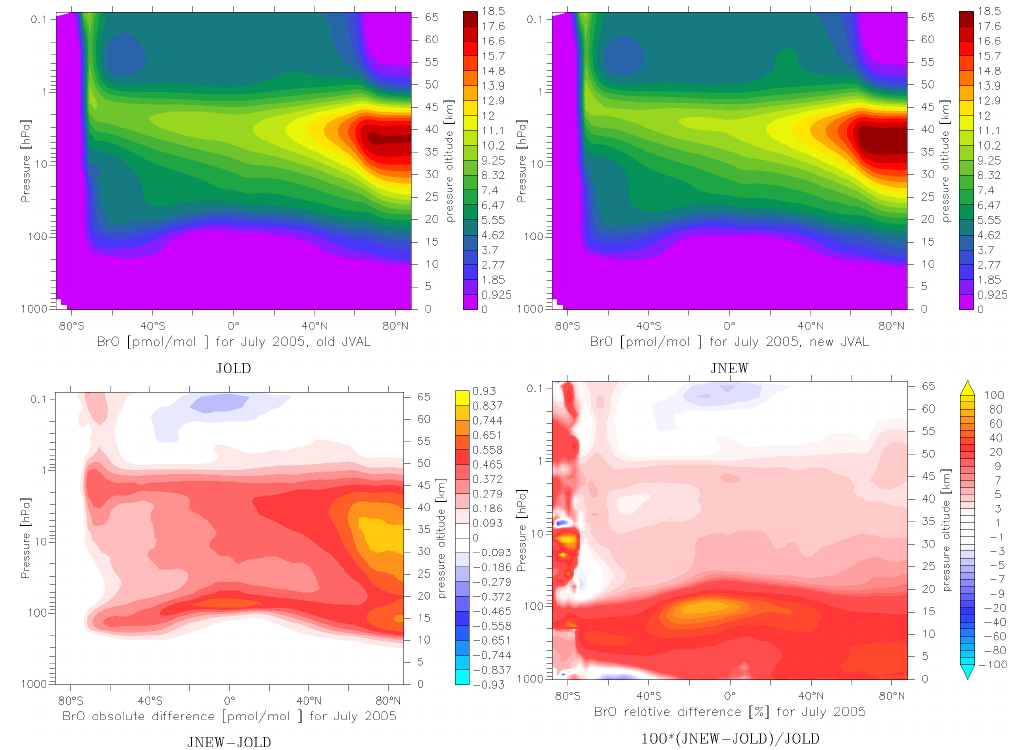
Figure 5. Effect of updated J values on BrO . All plots refer to zonally averaged monthly mean values of July 2005. Geosci. Model Dev., 7, 2653–2662, 2014